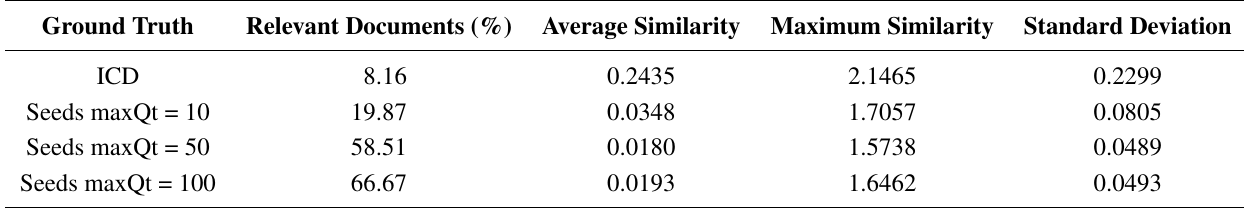
Table 6. Statistics on Twitter based crawl.